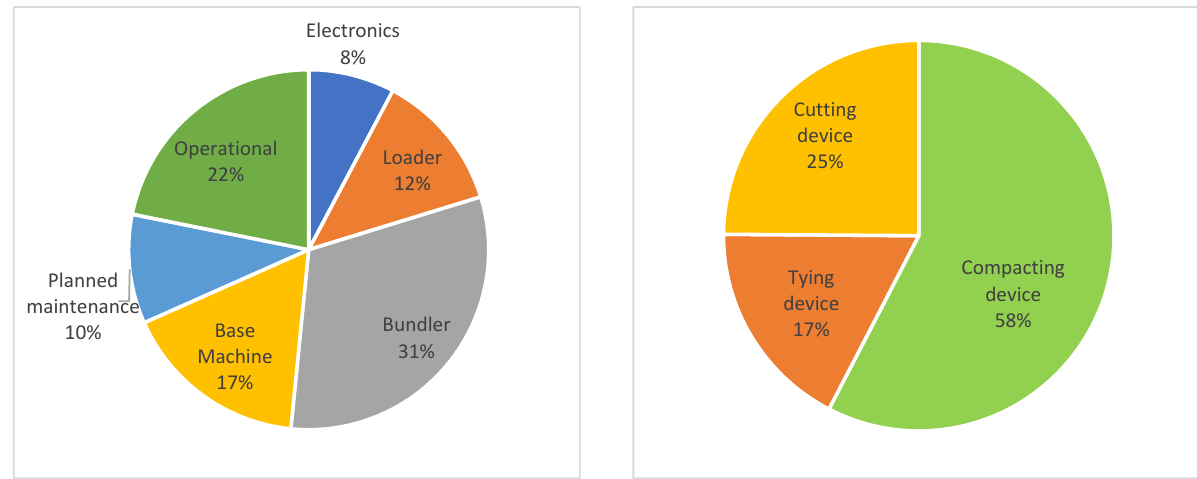
Figure 4. Reported causes for downtime: frequency of events for the whole machine ( left ) and the bundling unit only ( right ).